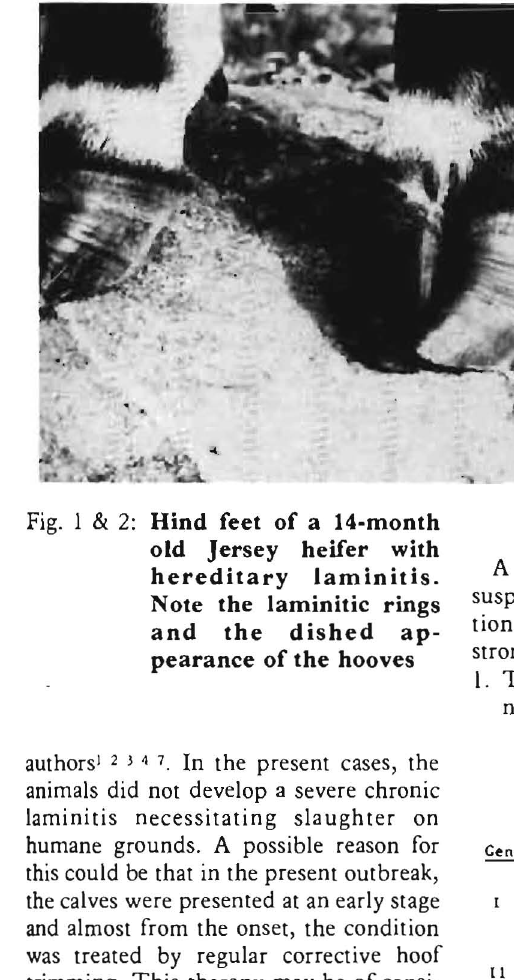
Fig. 3: Genealogic diagram showing the close relationship be tween the 6 Jersey calves af fected with hereditary laminitis and the inbreeding which occurred in the pedi gree of the American Jersey bull FO. The bull SEK in the diagram is the locally-bred Zimbabwean Jersey bull